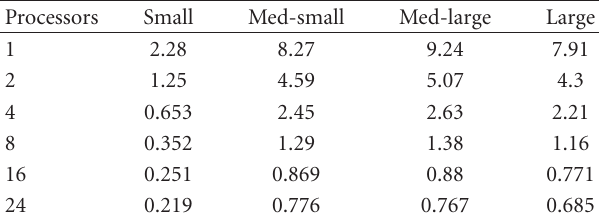
Table 5: Image interpolation timing (in